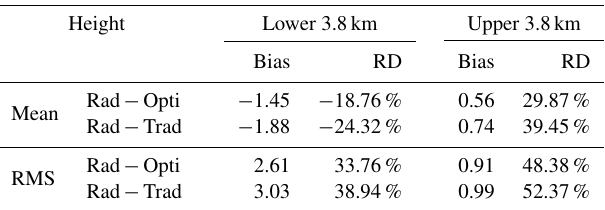
Table 5. Statistics for tomography-derived and radiosonde-derived water vapor density above and below 3.8km (gm − 3 ). Rad is the radiosonde-derived water vapor density, Opti is the optimized tomography-derived water vapor density, and Trad is the traditional tomography-derived water vapor